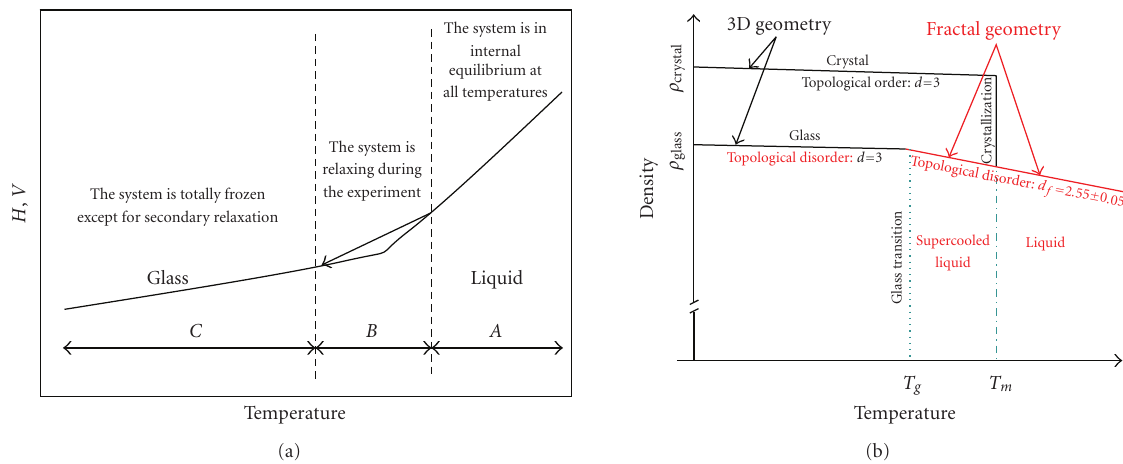
Figure 3: (a) Regions of relaxation behaviour of amorphous materials (after [29]); (b) density and geometry of bonds on increase of temperature (after [6]).